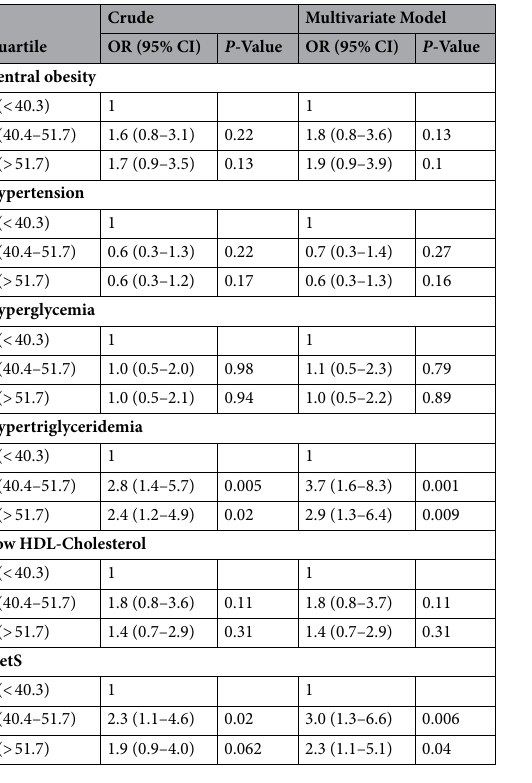
Table 3. Logistic Regression analysis for ZAG tertile on MetS and its components. Data presented Odd Ratio (95% CI). P -value < 0.05, 0.01 level will be significant. Multivariate logistic regression analysis was adjusted for